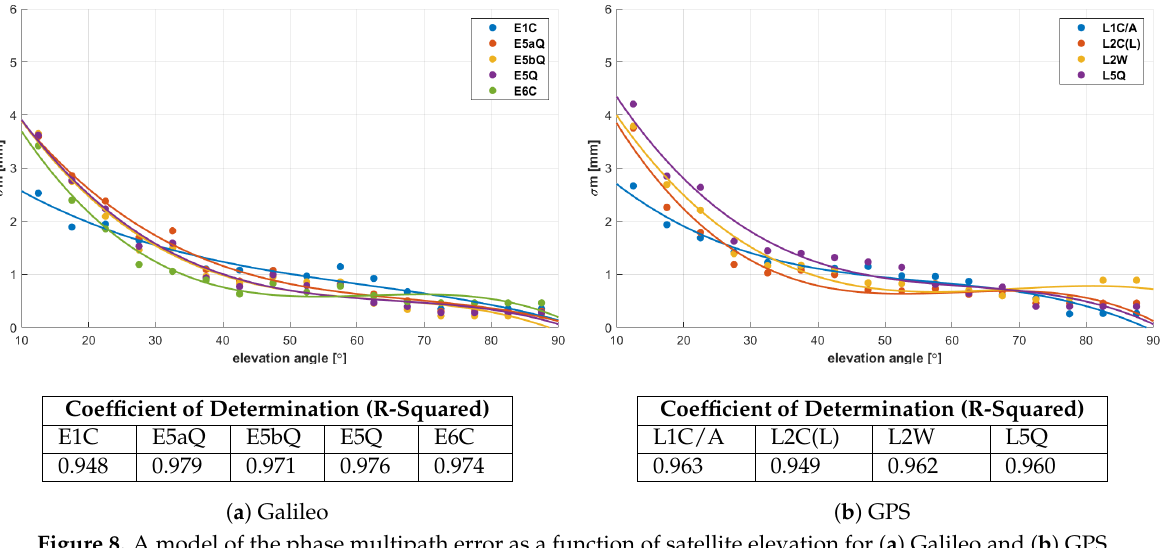
Figure 8. A model of the phase multipath error as a function of satellite elevation for ( a ) Galileo and ( b ) GPS. Table 3. Standard deviation of phase multipath error for a specified elevation estimated on the basis of the